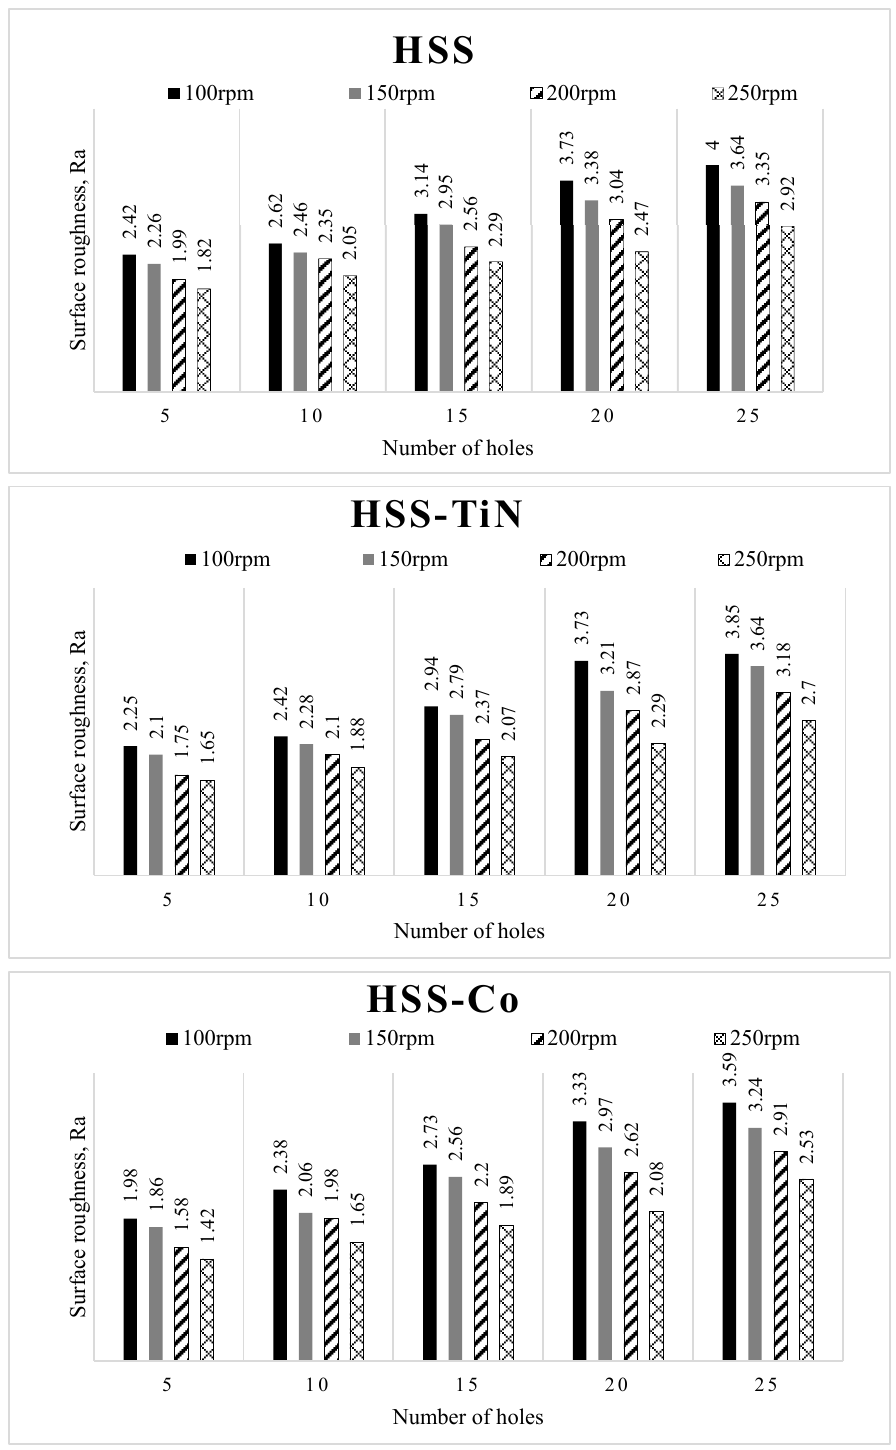
Figure 9. Surface roughness value of the cutting tools.